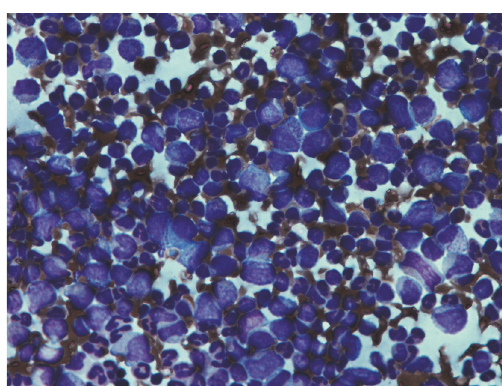
Figure 2: The bone marrow aspirate shown above demonstrates a “left-shift” in granulopoiesis, especially with a significant increase in myelocytes, promyelocytes, and metamyelocytes.